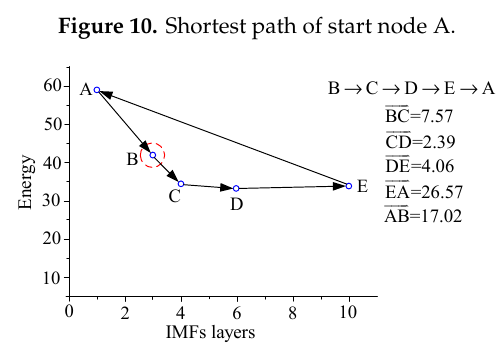
Figure 11. Shortest path of start node B.